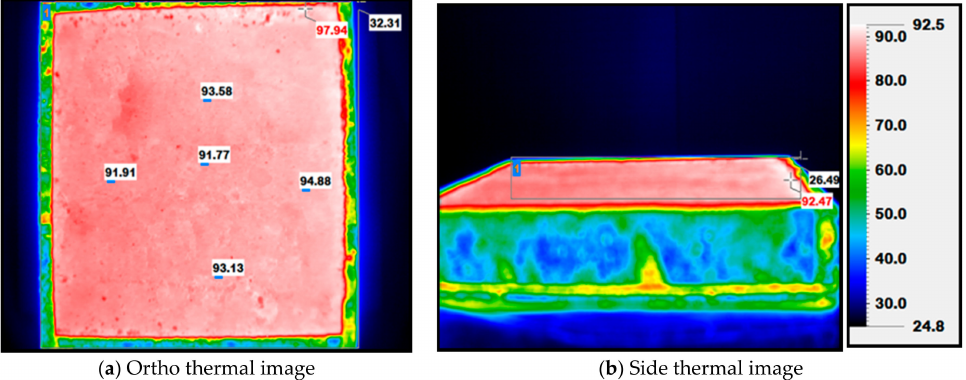
Figure 8. Dense-graded mixture thermal image ( ◦